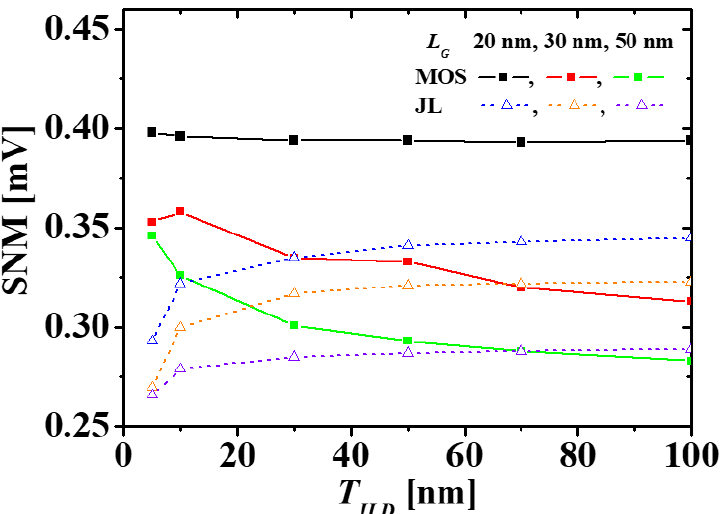
Figure 9. SNMs of M3INV-MOS and M3INV-JL cells at different T ILD s . Filled and empty symbols denote SNMs of M3INV-MOS and M3INV-JL with T ILD = 5, 10, 50, and 100 nm, respectively. Squares, circles, and triangles denote SNMs of M3INV-MOS and M3INV-JL with L G = 20, 30, and 50 nm, respectively.